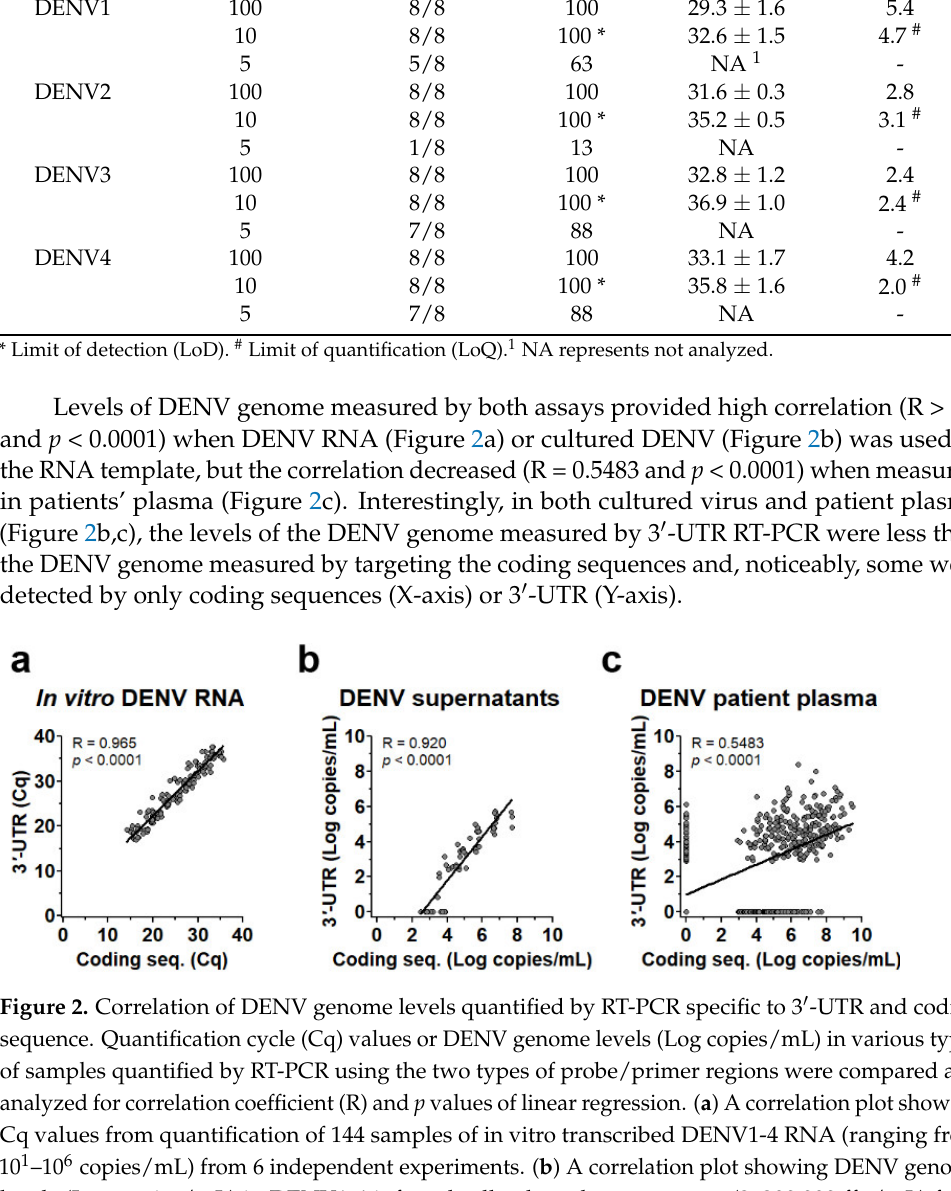
Table 6. Limit of detection and limit of quantification of coding sequence RT-PCR assay. Serotypes